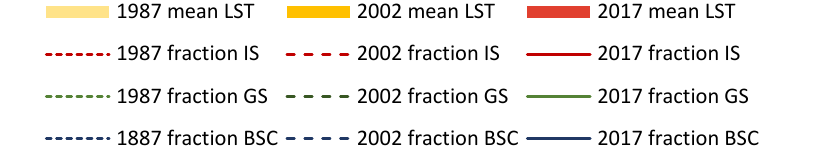
Figure 6. Mean LST and fractions of impervious surface (IS), green space (GS) and baresoil and cultivated land (BSC) along the urban-rural gradient.